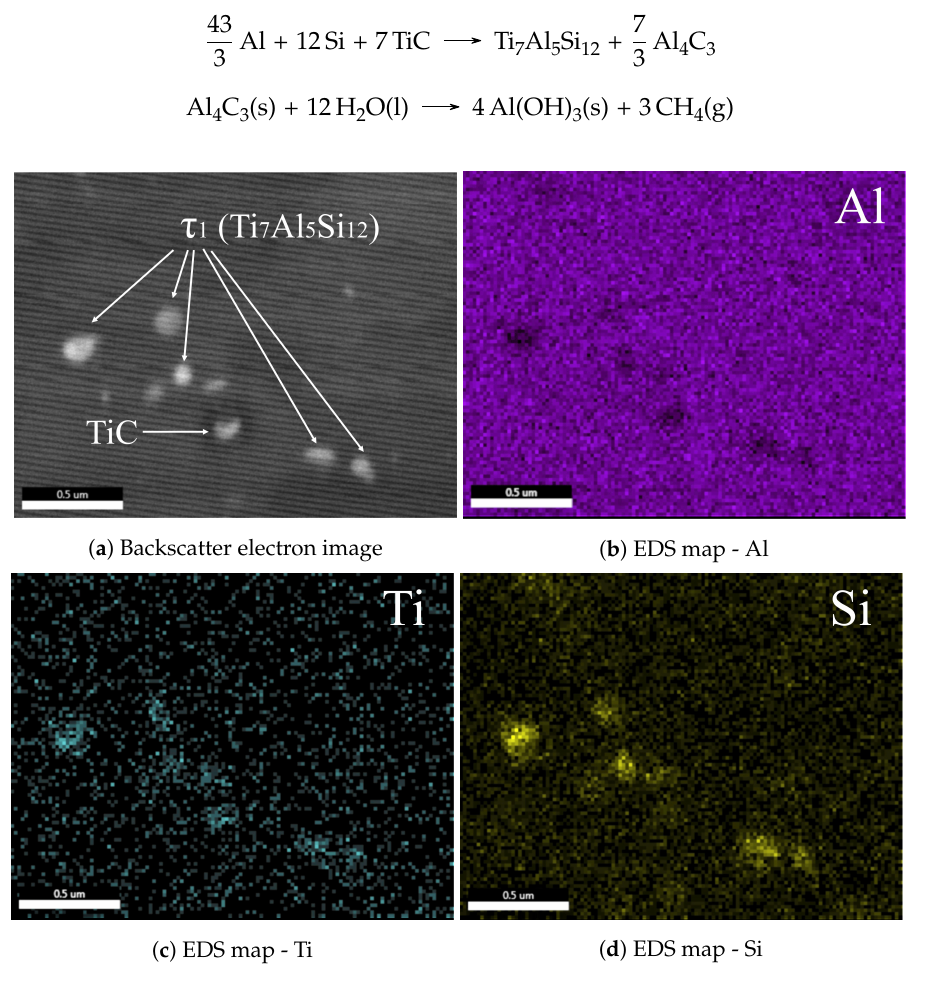
Figure 6. EDS map of metal screw extruded AA4043-TiC feedstock wire showing presence of two different Ti-containing phases: Ti 7 Al 5 Si 12 ( τ 1 ) and